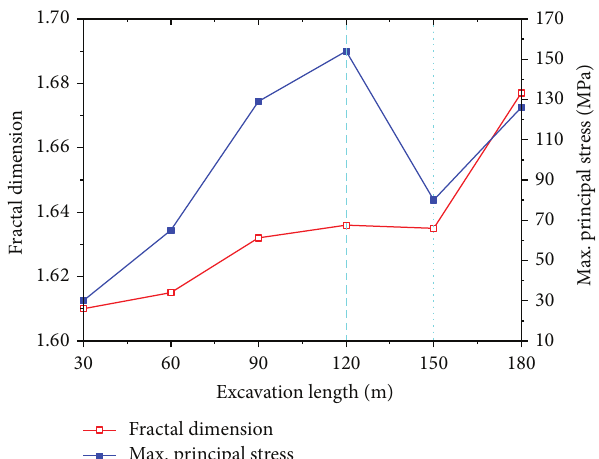
Figure 6: Plot of maximum stress around work face and fractal dimension with excavation